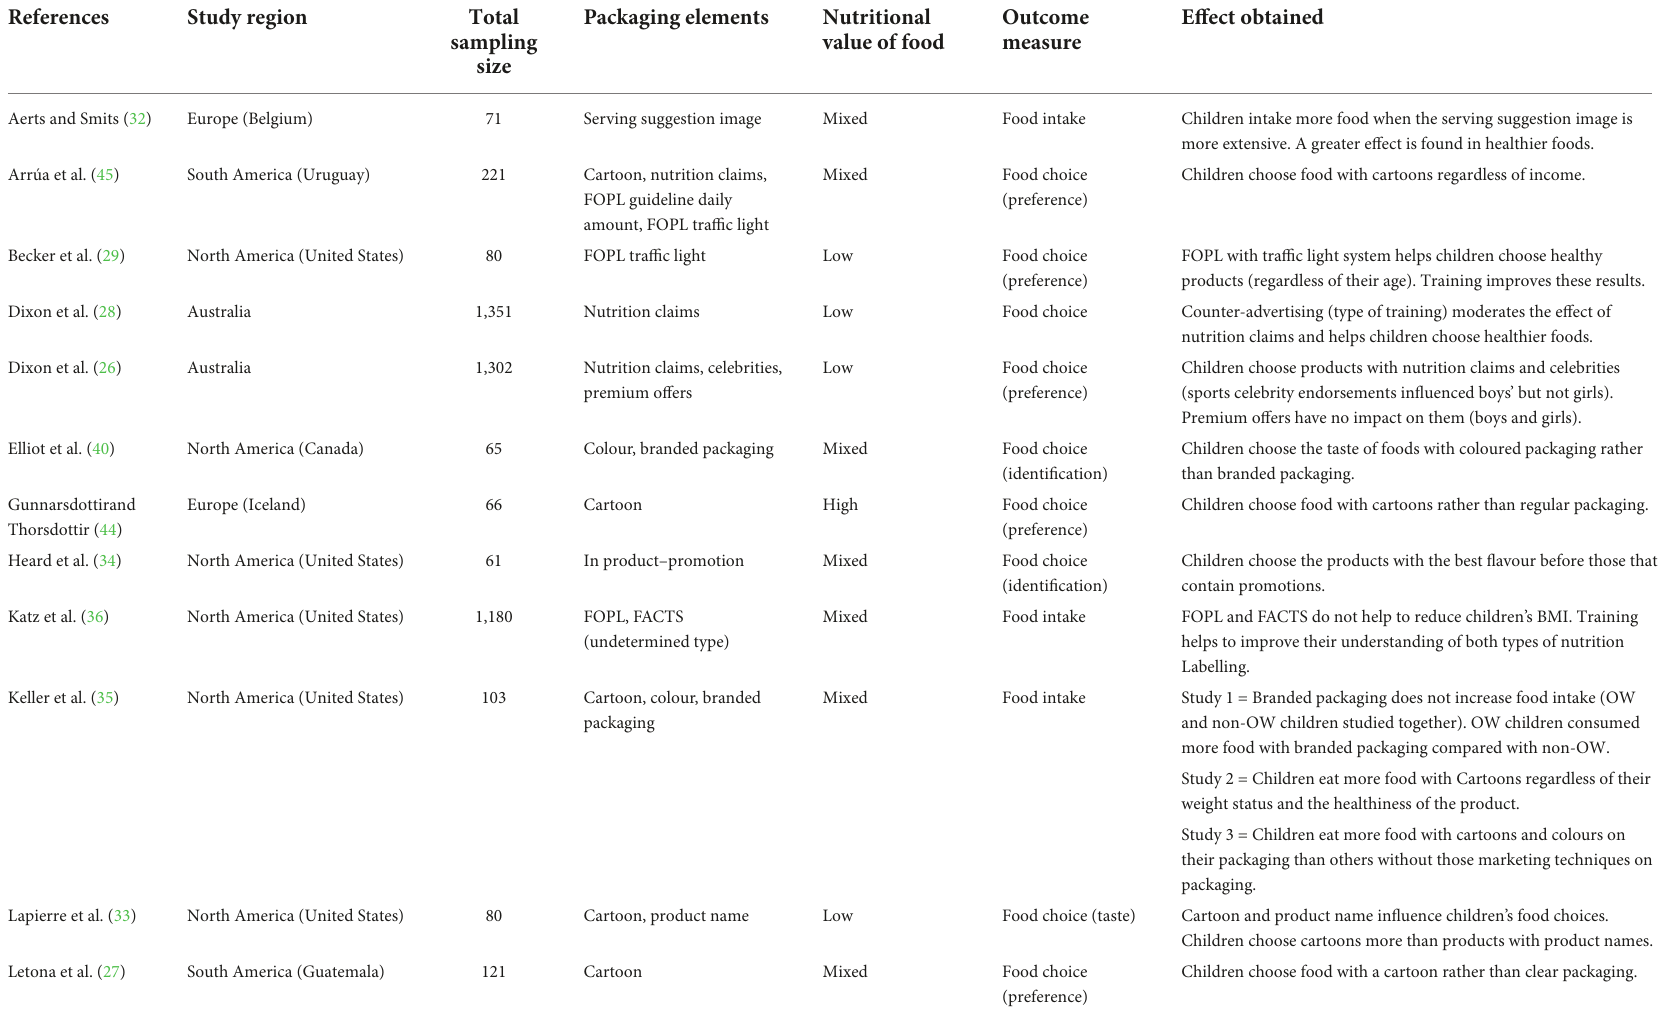
TABLE 2 Key results of included